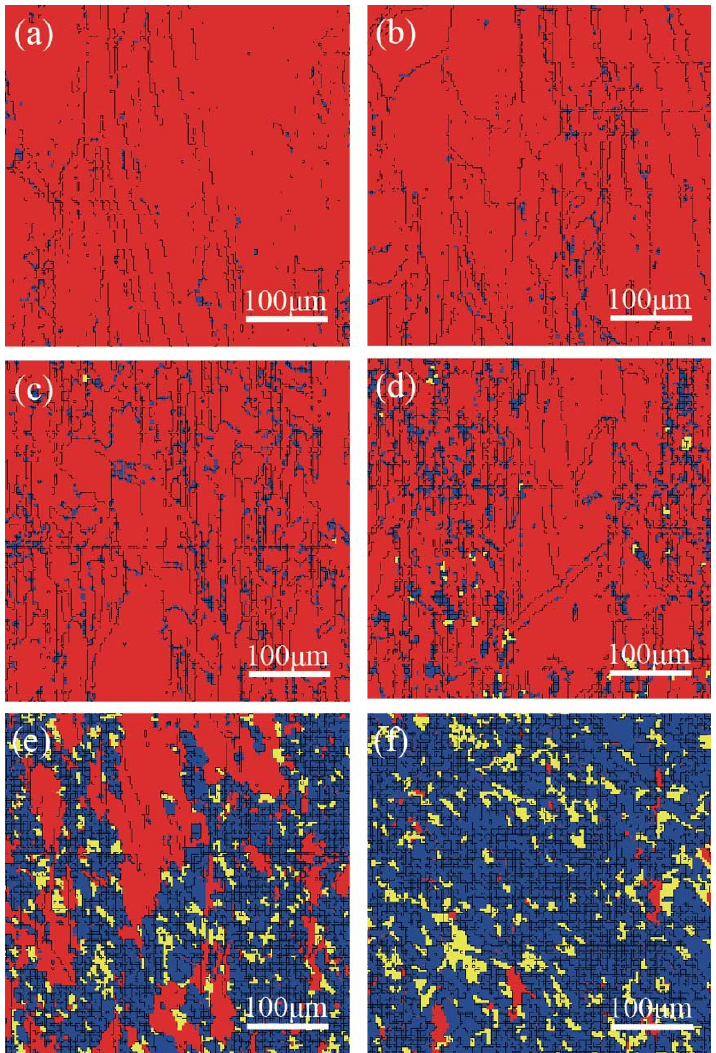
Figure 3. Structure evolution of cold ‐ drawn Cu–Cr–In alloy after annealing. ( a ) 450 °C, 60 min; ( b ) 450 °C, 240 min; ( c ) 550 °C, 60 min; ( d ) 550 °C, 240 min; ( e ) 650 °C, 60 min; ( d ) 650 °C, 240 min.